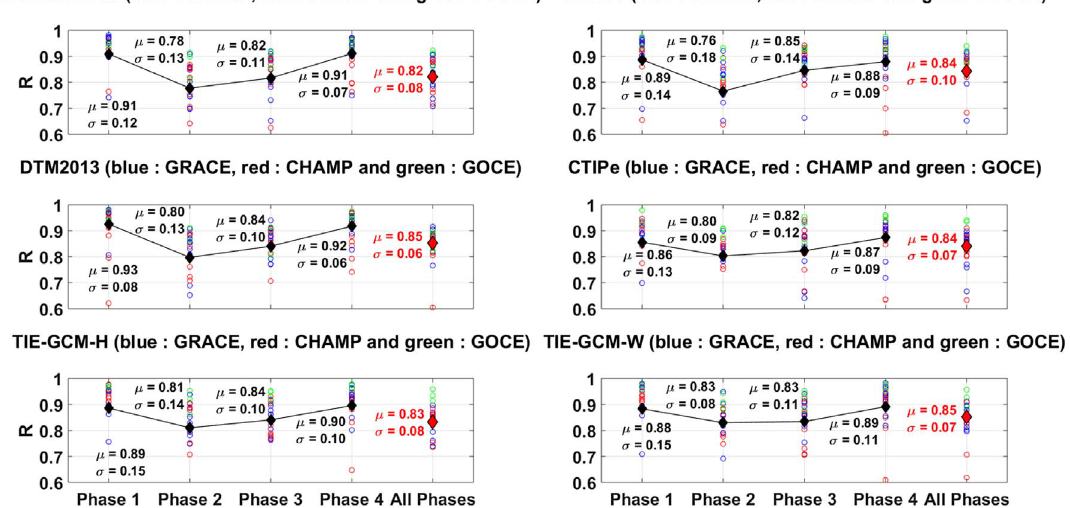
Fig. 6. The mean l and standard deviation r of the 24 correlation coef fi cients per phase (black) and overall (red), using data from three satellites.